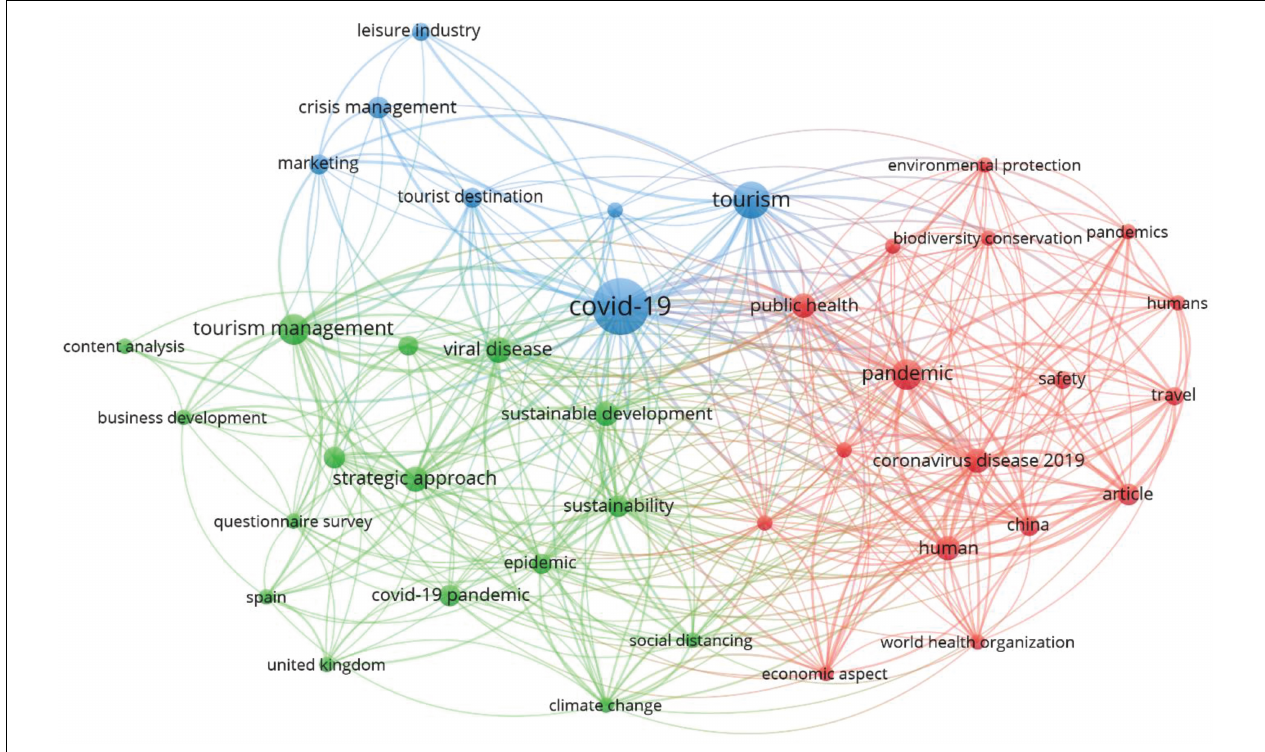
FIGURE 5 | Co-occurrence network